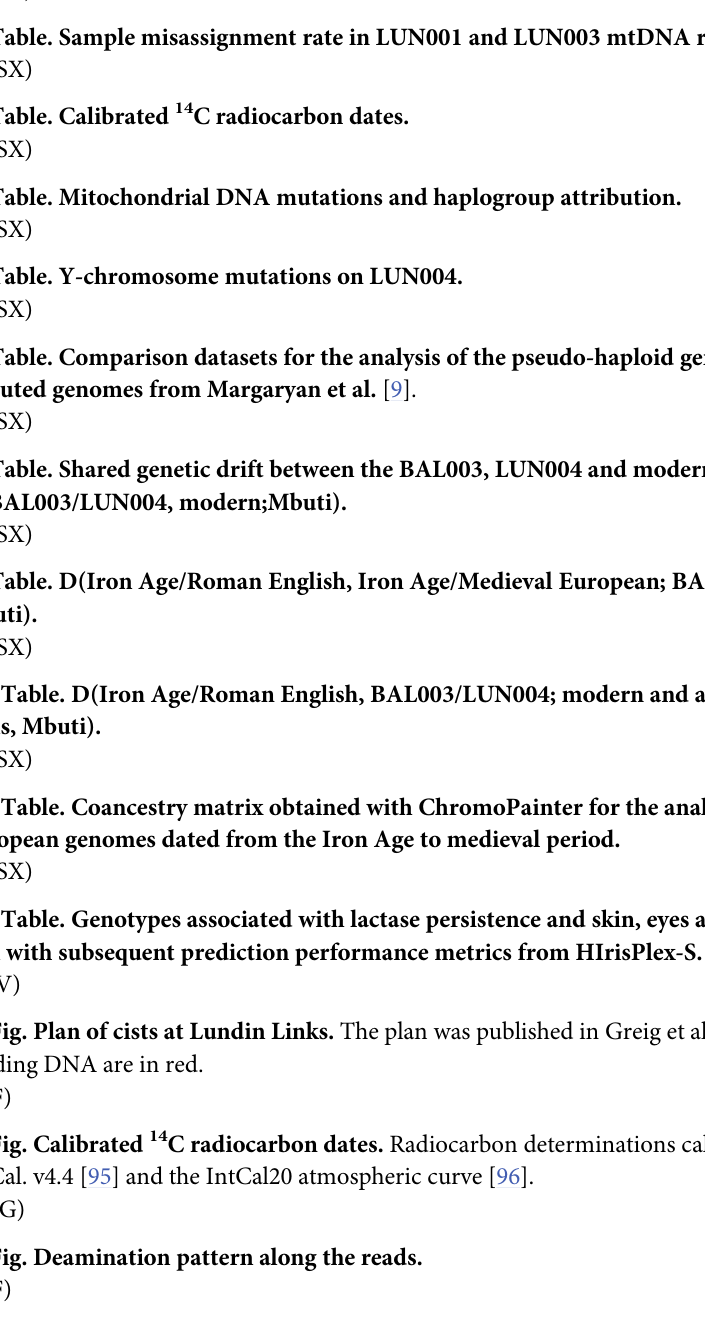
S1 Table. DNA sample information from eight Pictish genomes in this study. (XLSX) S2 Table. Sample misassignment estimate in LUN001 and LUN003 using qpAdm. (XLSX) S3 Table. Sample misassignment rate in LUN001 and LUN003 mtDNA reads. S4 Table. Calibrated 14 C radiocarbon dates. S5 Table. Mitochondrial DNA mutations and haplogroup attribution. (XLSX) S6 Table. Y-chromosome mutations on LUN004. S7 Table. Comparison datasets for the analysis of the pseudo-haploid genomes and imputed genomes from Margaryan et al. [9]. S8 Table. Shared genetic drift between the BAL003, LUN004 and modern populations as f3(BAL003/LUN004, modern;Mbuti). S9 Table. D(Iron Age/Roman English, Iron Age/Medieval European; BAL003/LUN004, Mbuti). S10 Table. D(Iron Age/Roman English, BAL003/LUN004; modern and ancient popula- tions, Mbuti). S11 Table. Coancestry matrix obtained with ChromoPainter for the analysis of 284 ancient European genomes dated from the Iron Age to medieval period. S12 Table. Genotypes associated with lactase persistence and skin, eyes and hair pigmenta- tion with subsequent prediction performance metrics from HIrisPlex-S. S1 Fig. Plan of cists at Lundin Links. The plan was published in Greig et al. [36]. The samples yielding DNA are in red. S2 Fig. Calibrated 14 C radiocarbon dates. Radiocarbon determinations calibrated using OxCal. v4.4 [95] and the IntCal20 atmospheric curve [96]. S3 Fig. Deamination pattern along the